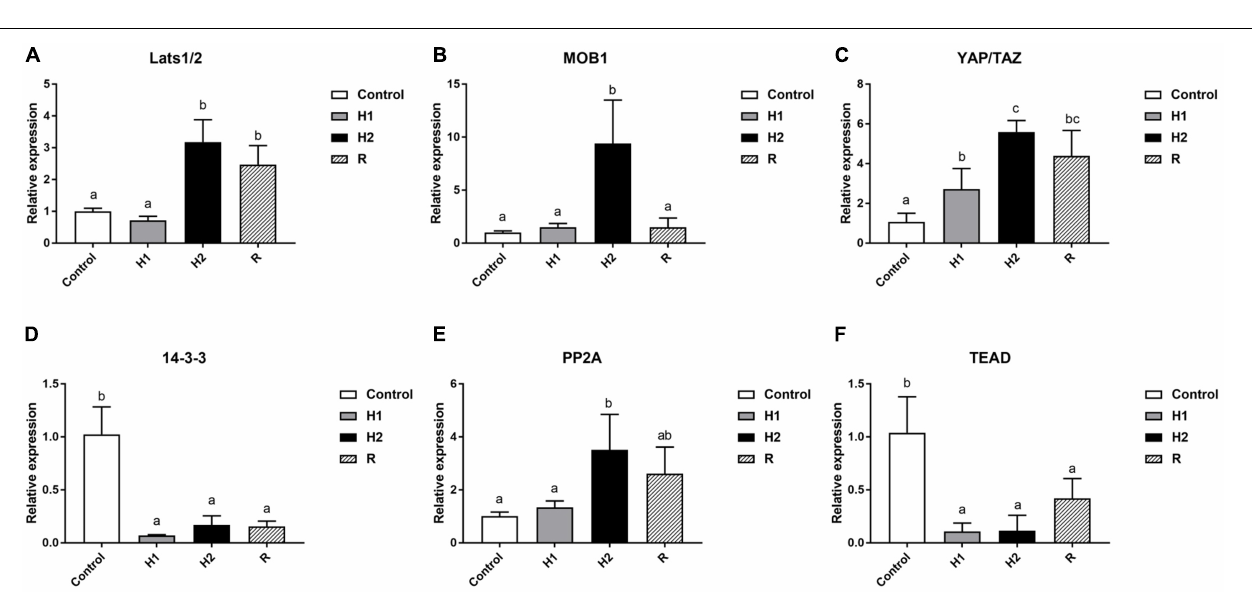
FIGURE 8 | Effects of hypoxia and reoxygenation on Hippo pathway genes. (A) The expression level of large tumor suppressor homolog 1/2 (Lats1/2) gene. (B) MOB kinase activator 1 (MOB1) expression level. (C) Yes-associated protein/transcriptional co-activator with PDZ-binding motif (YAP/TAZ) expression. (D) The expression of 14-3-3. (E) The expression level of Protein Phosphatase 2A (PP2A). (F) The expression level of TEA domain (TEAD) gene. Different lowercase letters above each bar represent significant differences ( P <